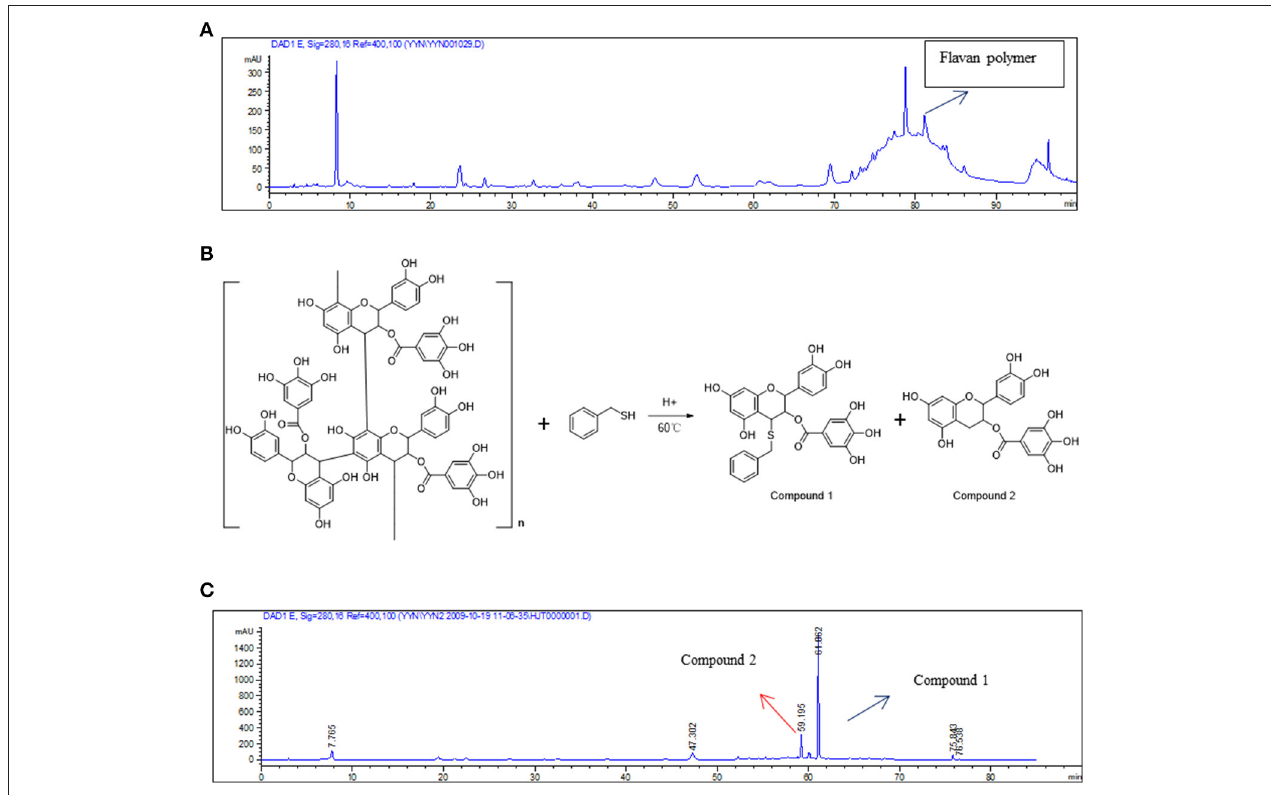
FIGURE 1 | Analysis of chemical constituents in RC-3. (A) HPLC analysis of RC-3. (B) Acid-mediated depolymerization of flavan polymers in the presence of thiol nucleophiles. (C) HPLC analysis of the thiolysis of the RC-3.